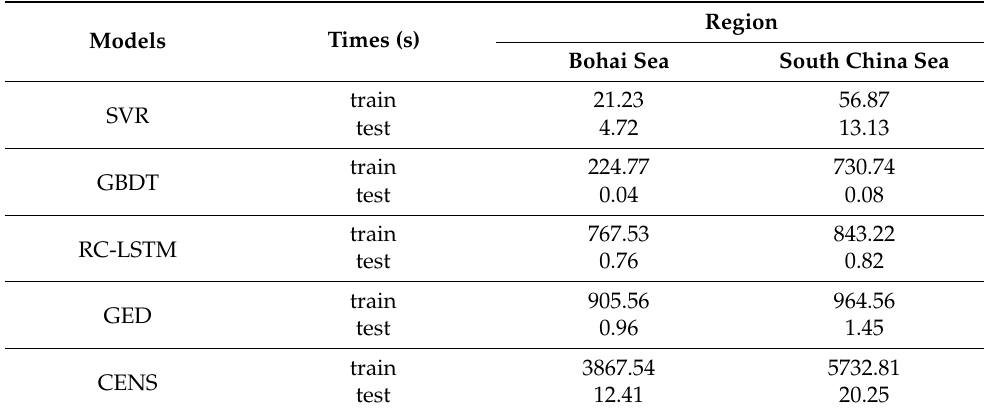
Table 3. The elapsed time of each